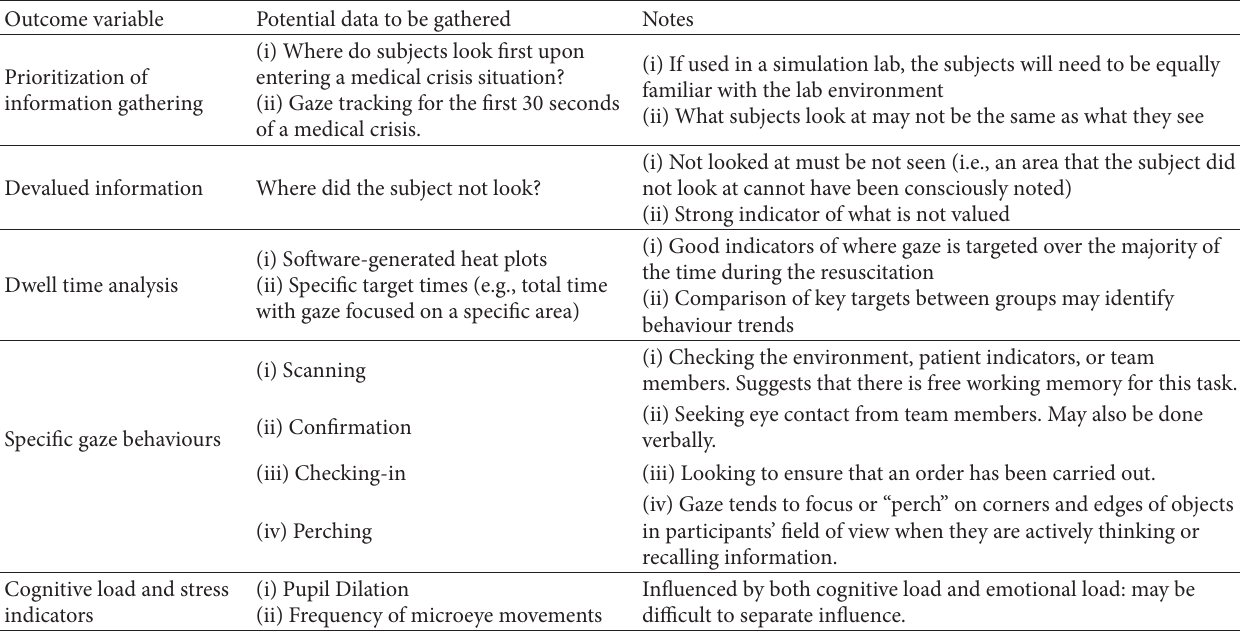
Table 1: Potential outcome measures for future studies that were identified during data